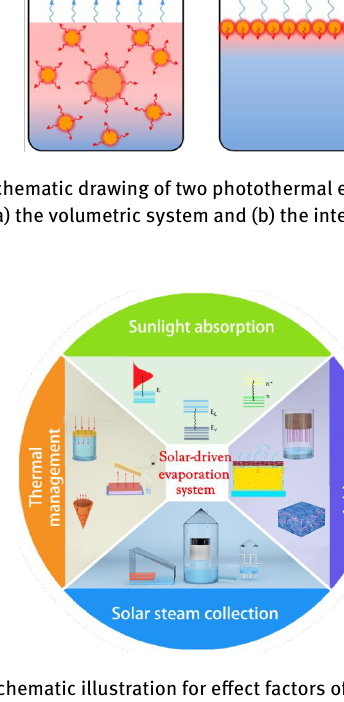
Figure 2: Schematic illustration for effect factors of solar-driven evaporation